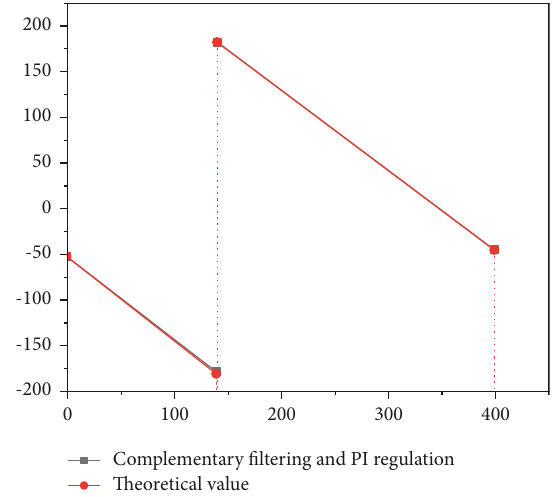
Figure 6: Comparison of course angle calculation results and theoretical values based on complementary filtering and PI ad- justment under high dynamic. Table 2: Attitude calculation error based on gradient descent, complementary filtering, and PI adjustment under high dynamic.